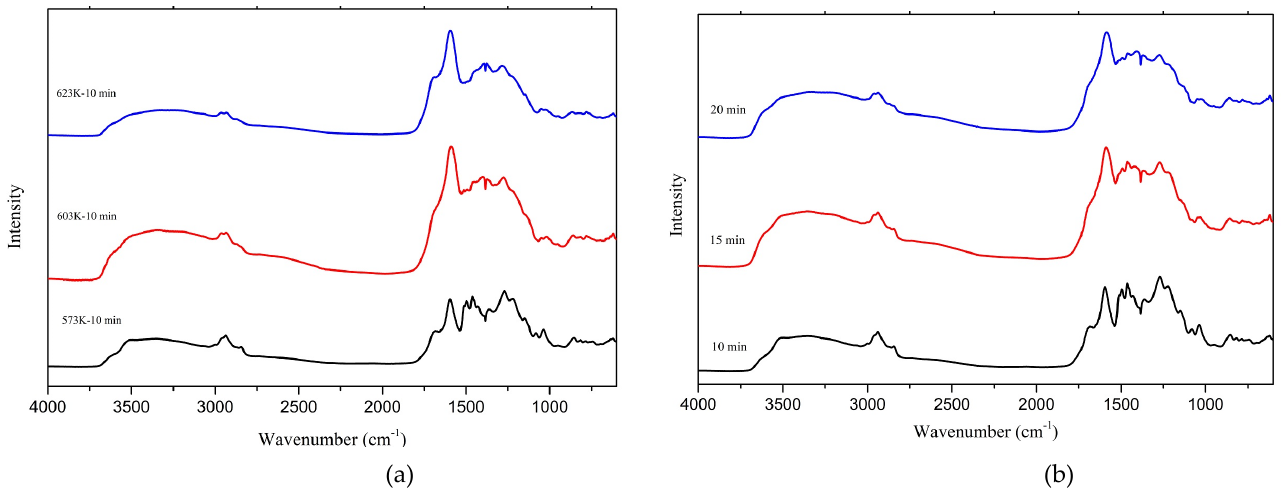
Figure 4. FTIR spectra of chars from ( a ) different temperatures with a 10 min residence time ( b ) different residence times at 573 K.